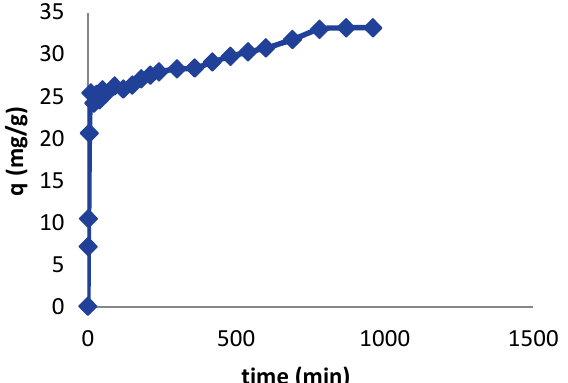
Figure 7. Equilibrium time curve of humic acid (HA) absorption on activated acid (AC) Adsorption isotherms are equilibrium data